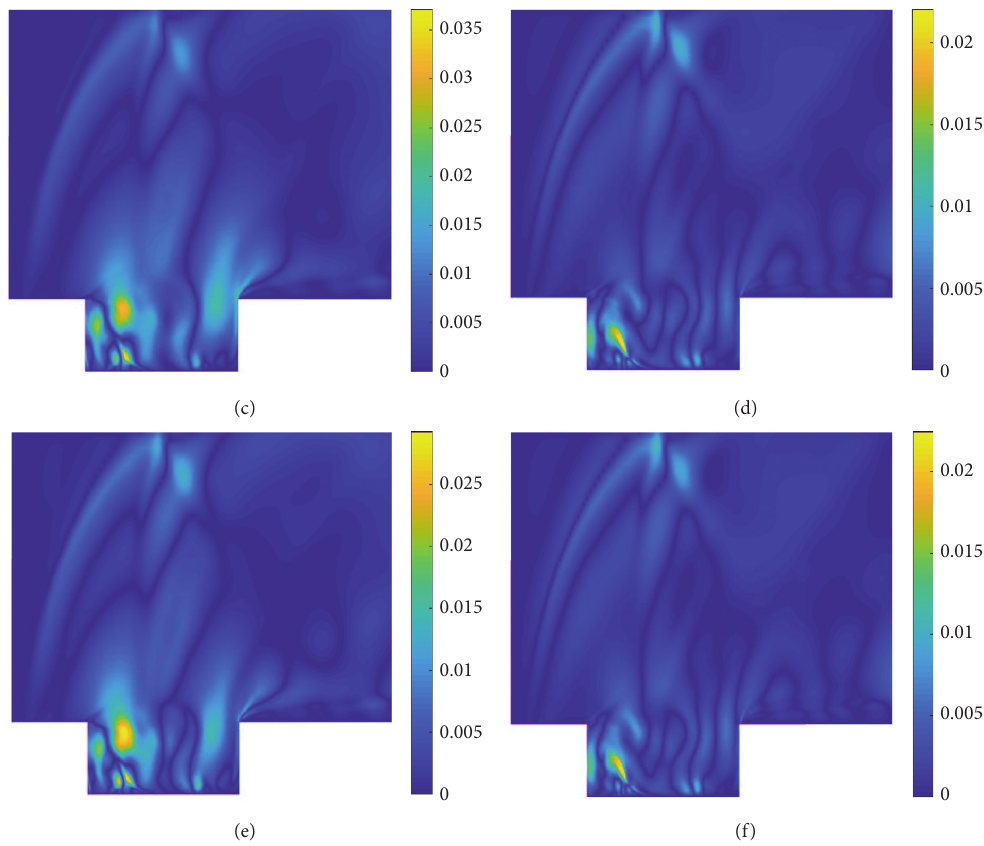
Figure 14: Comparison of RMSE predicted by two deep learning frameworks (Ma � 0.56, 0.57, 0.58). (a) RMSE (MLP, Ma � 0.56), (b) RMSE (LSTM, Ma � 0.56), (c) RMSE (MLP, Ma � 0.57), (d) RMSE (LSTM, Ma � 0.57), (e) RMSE (MLP, Ma � 0.58), and (f) RMSE (LSTM, Ma �